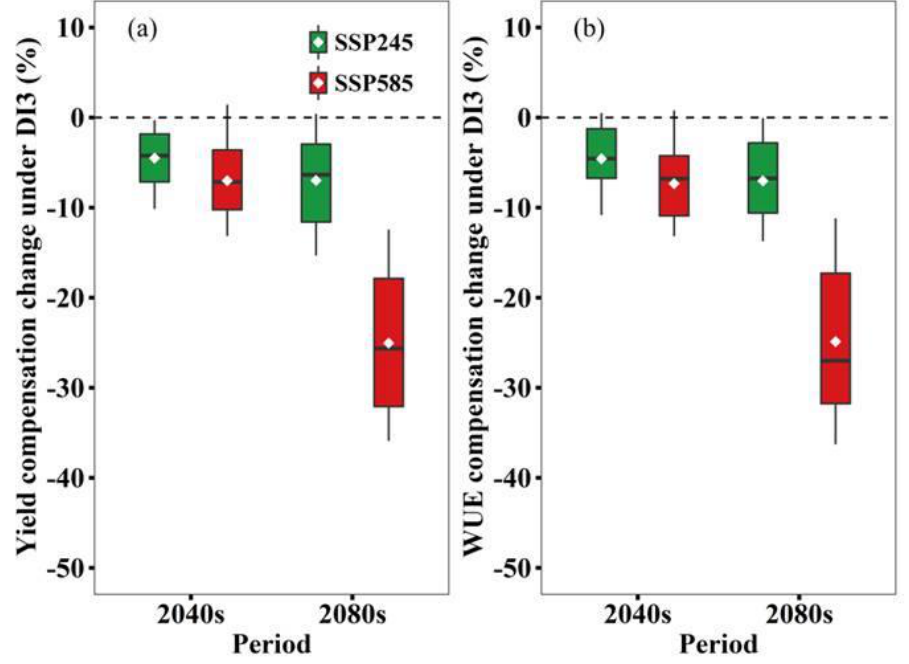
Figure 6. Compensation changes in yield ( a ) and WUE ( b ) under DI3 in the 2040s and 2080s relative to the baseline period under SSP245 and SSP585 based on 21 GCMs when N fertilizer rate is 150 kg ha − 1 (N3). Box boundaries indicate the 25th and 75th percentiles across GCMs, and whiskers below and above the box denote as the 10th and 90th percentiles. The black lines and white dots inside the box indicate the multi-model median and mean, respectively.